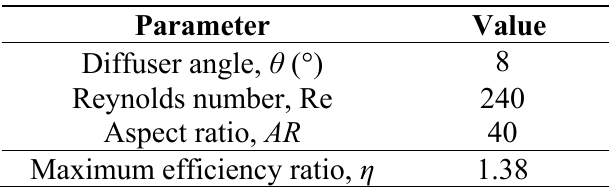
Table 8. Parameters associated with the diffuser element to obtain the highest efficiency ratio.